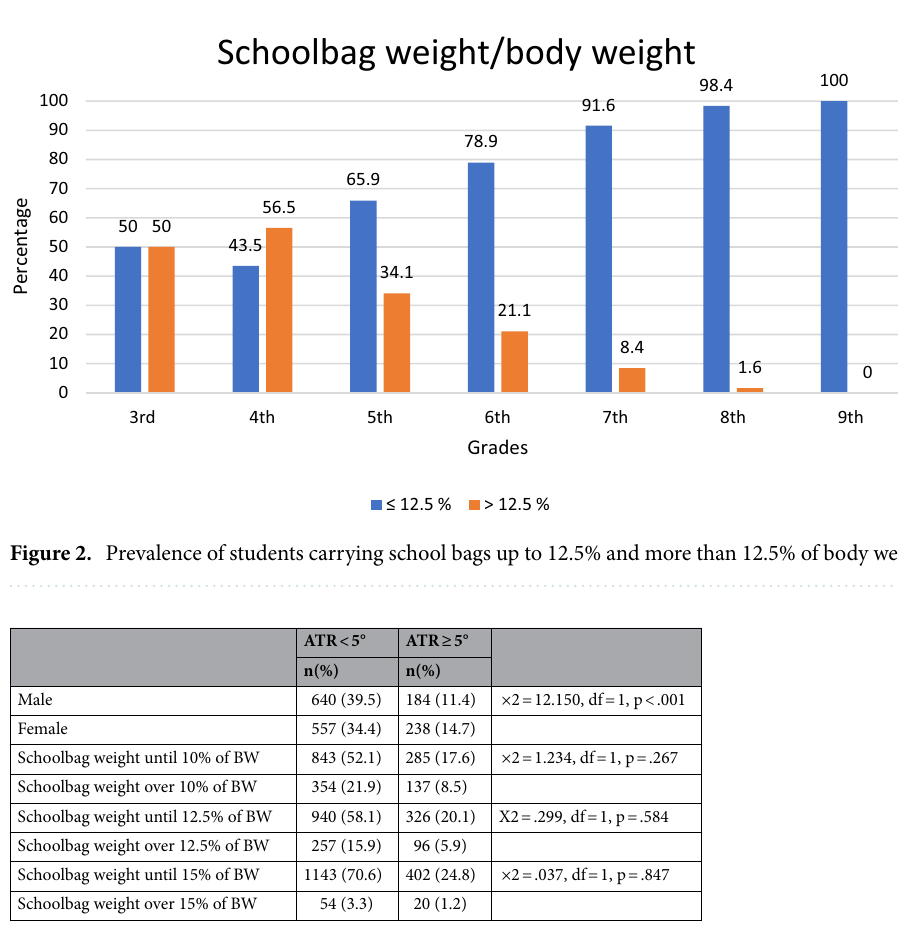
Table 2. Frequency distributions of the angle of trunk rotation according to gender and schoolbag weight to body weight rate. ATR, angle of trunk rotation; BW, body weight.